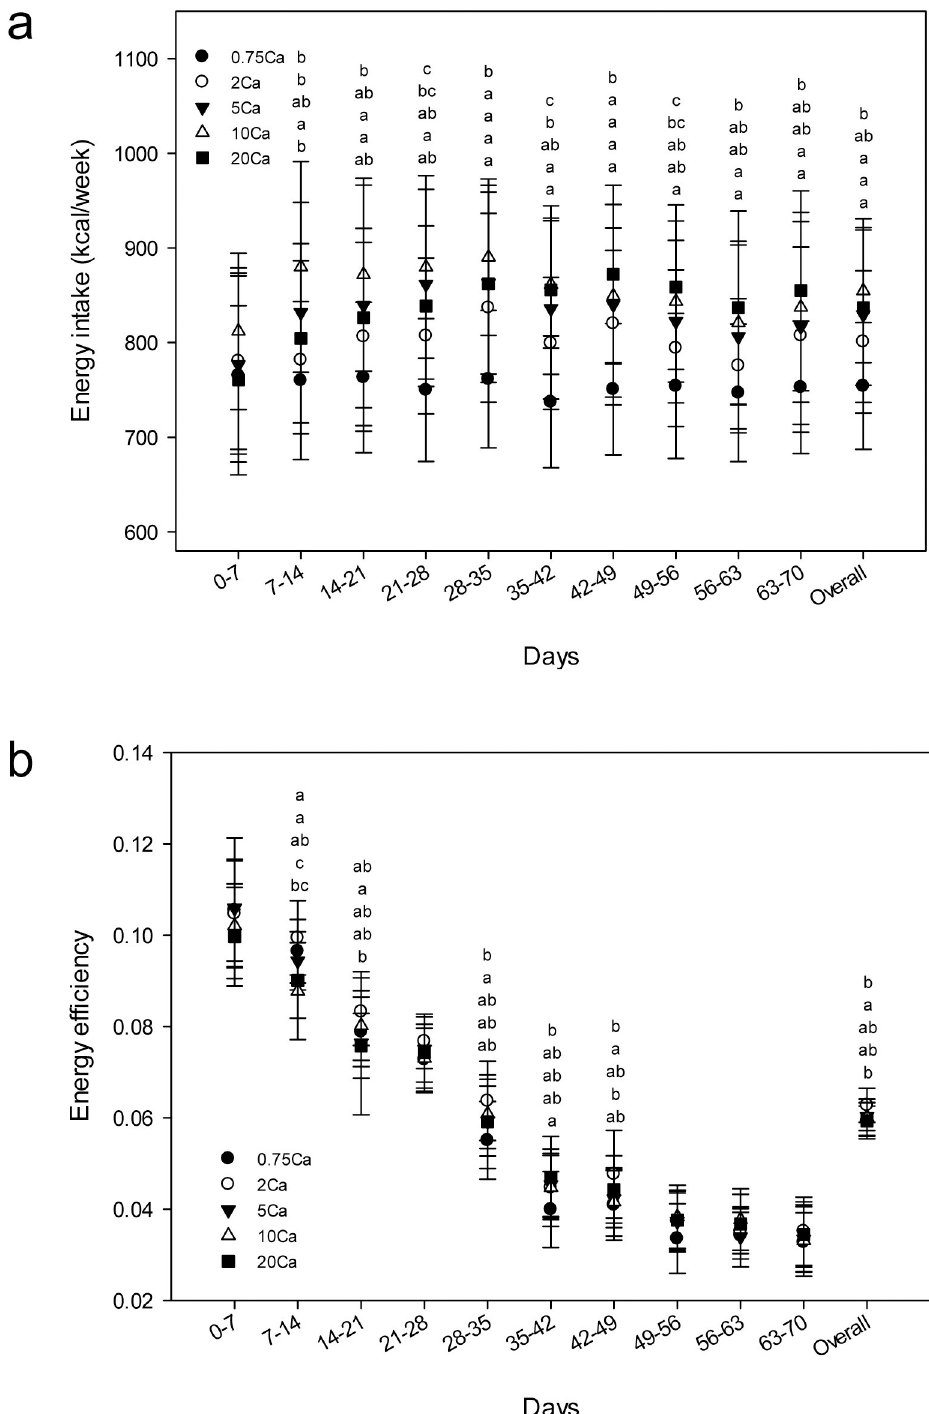
Fig 2. Energy intake (a) and energy efficiency (b) of rats. Results are presented as means ± SD, n = 28–30. Results were analyzed by mixed-design ANOVA to determine effects and interaction of diet and time. For time points with a significant ( p < 0.05) diet effect, differences among diet groups were determined using one-way ANOVA followed by the Holm-Sidak post-hoc test. Diet groups without a common letter differ, p < 0.05. Letters correspond to diet groups 0.75Ca, 2Ca, 5Ca, 10Ca and 20Ca sequentially from top to bottom. Overall energy intake was calculated by dividing the total energy intake for the entire study by the number of weeks of the study (10 weeks). Energy efficiency =